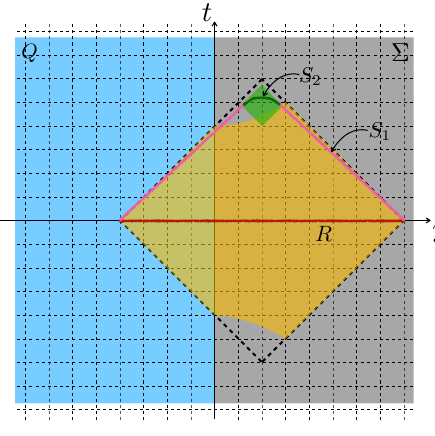
Figure 14 . A simple example showing the breakdown of tentative entanglement wedge nesting. Consider the identical setup with figure 13 and take a subregion S (shown in pink) such that 1 ∂S 1 = ∂R . By definition, E T ( S 1 ) = E T ( R ) and its intersection with Σ ∪ Q is shown in yellow. Consider S shown in dark green. Its entanglement wedge E ( S ) intersects Σ ∪ Q at the 2 ⊂ S 1 T 2 region shown in light green. Clearly, E ( S ) 6⊆ E ( S ) and hence tentative entanglement nesting T 2 T 1 breaks